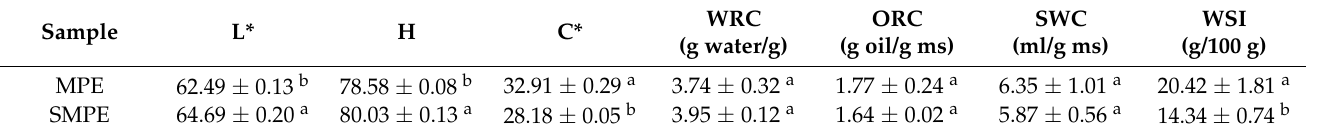
Table 8. Technological properties of umbu peels